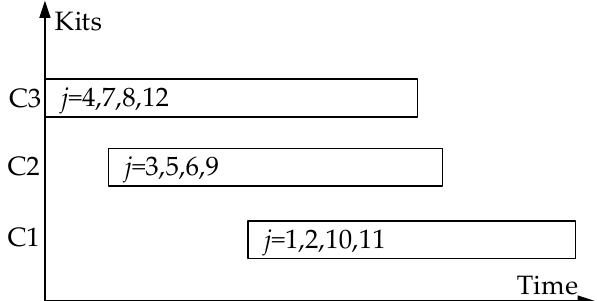
Figure 6. Gantt chart of kits scheduling.